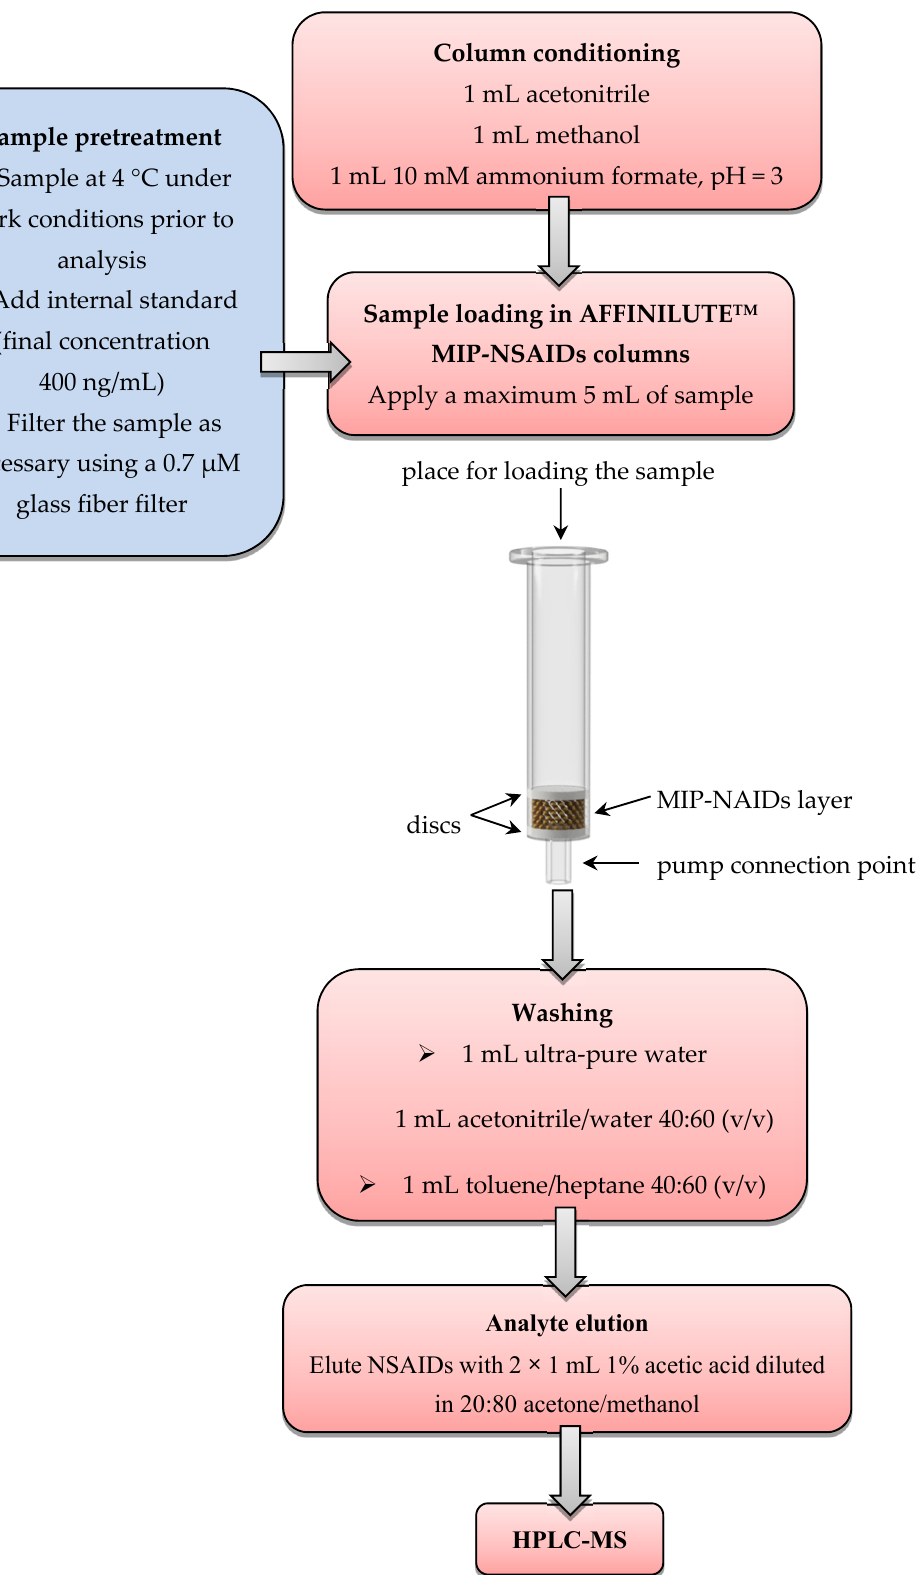
Figure 2. The analytical procedure for the determination of nonsteroidal anti-inflammatory drugs (NSAIDs) using an AFFINILUTE TM molecularly imprinted polymer MIP-NSAIDs column and HPLC-MS.